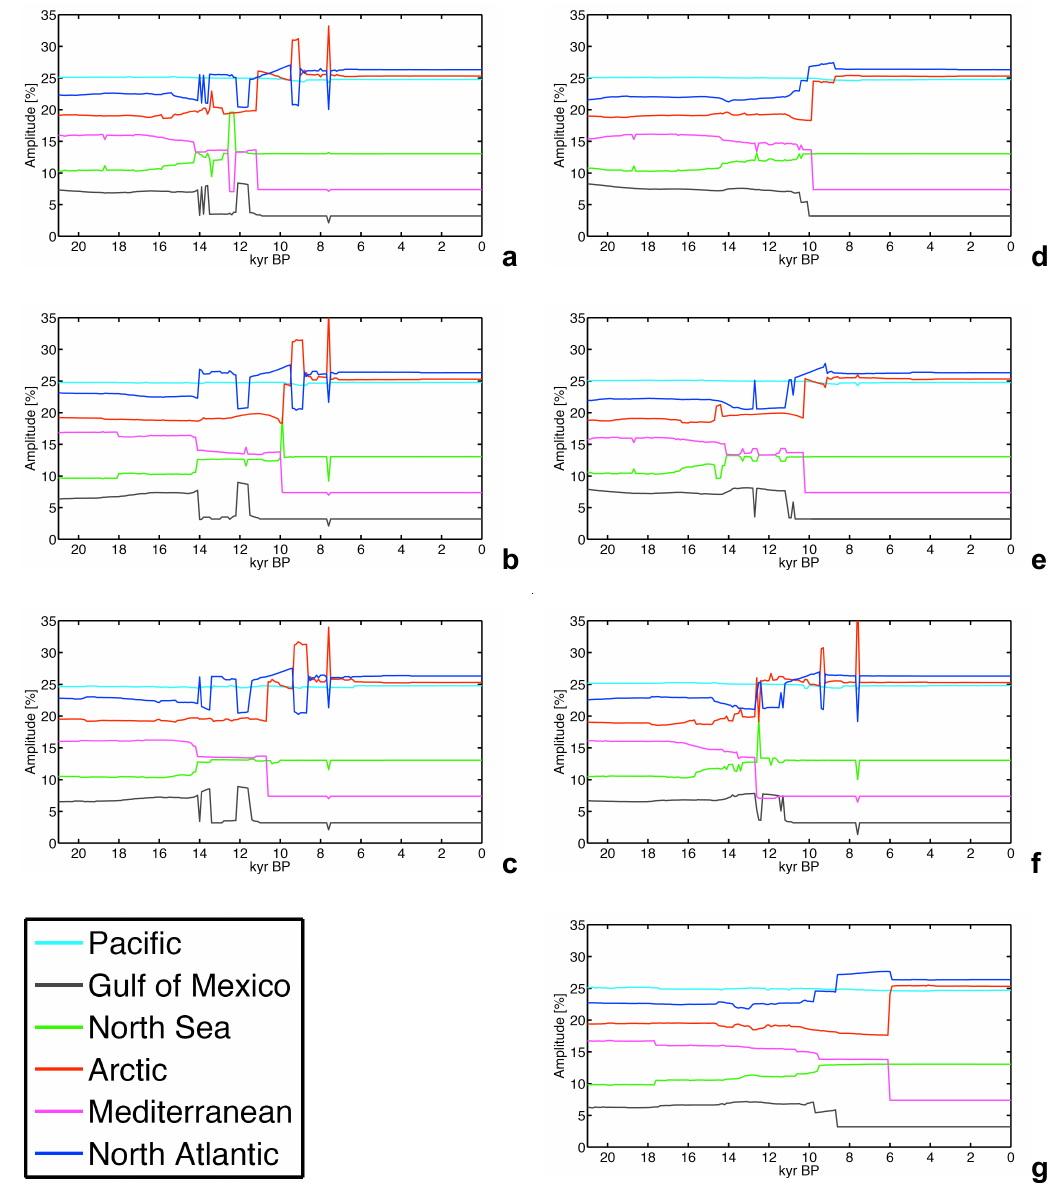
Fig. 9. Sensitivity of runoff partition between major oceanic basins to changes in the isostatic module of the ice sheet model. (a) Reference run [REF], changes of the lithospheric rigidity LR0.1 (b) , LR0 (c) and changes of adjustment time scale LT0k (d) , LT1k (e) , LT10k (f) , LTinf (g) . Parameter values are given in Table 1. The freshwater input was set spatially constant over the entire model domain in order to remove the effect of local freshwater availability. See text for details.